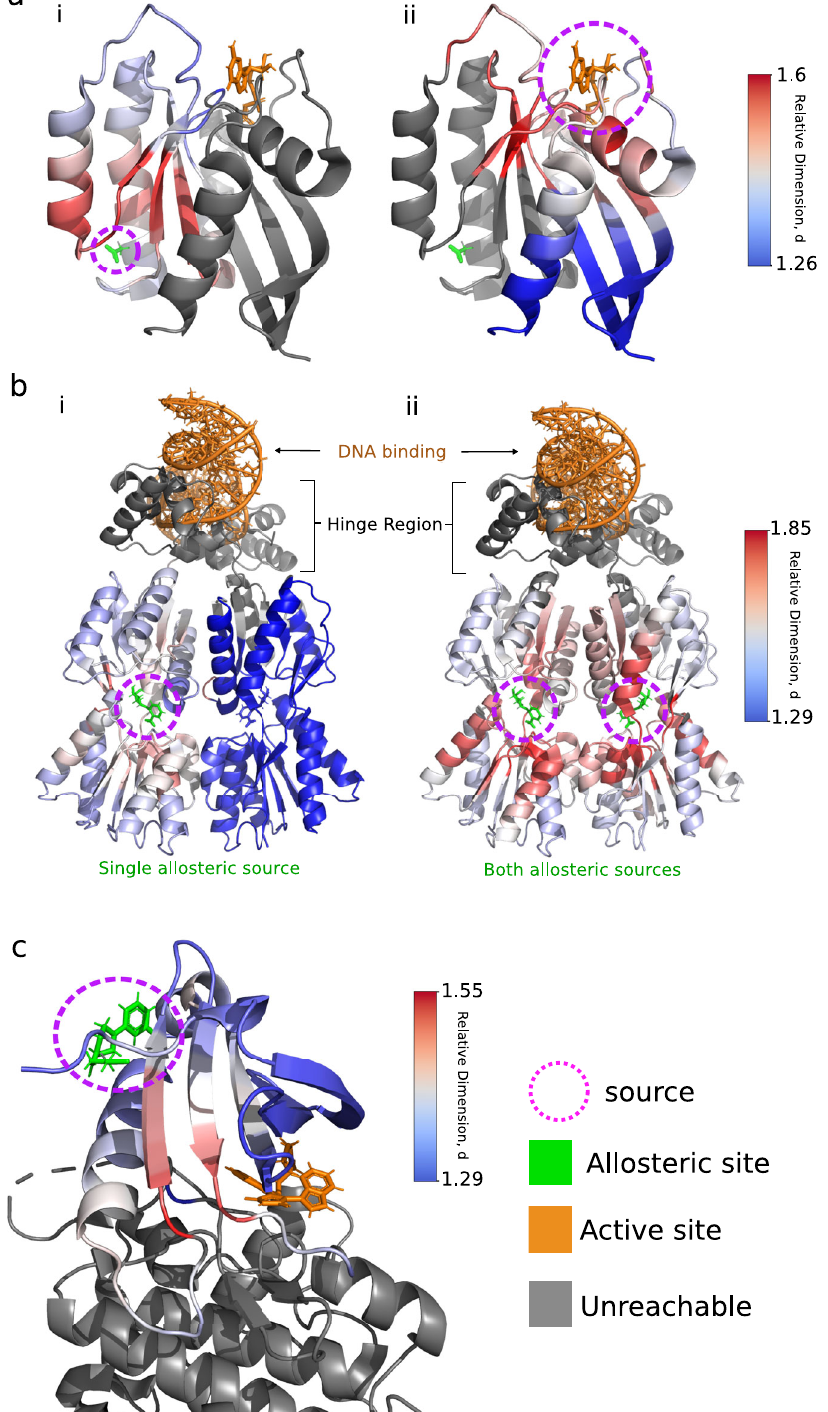
Fig. 3 Relative dimensions in allosteric proteins. Protein residues (amino acids) are coloured according to their relative dimension to the source region, where grey indicates that no peak in the transient response was identi fi ed and thus relative dimension could not be calculated. a The relative dimensions of all atoms in HRas GTPase (PDB ID: 3K8Y) given (i) the allosteric site and (ii) the active site as the source of diffusion. b Relative dimension in the multi- allosteric site Lac Repressor protein (PDB ID: 1EFA) given a (i) single allosteric site source and (ii) for both allosteric sites simultaneously. c The relative dimension give the allosteric site as the source in PDK1 (PDB ID: 3ORX).